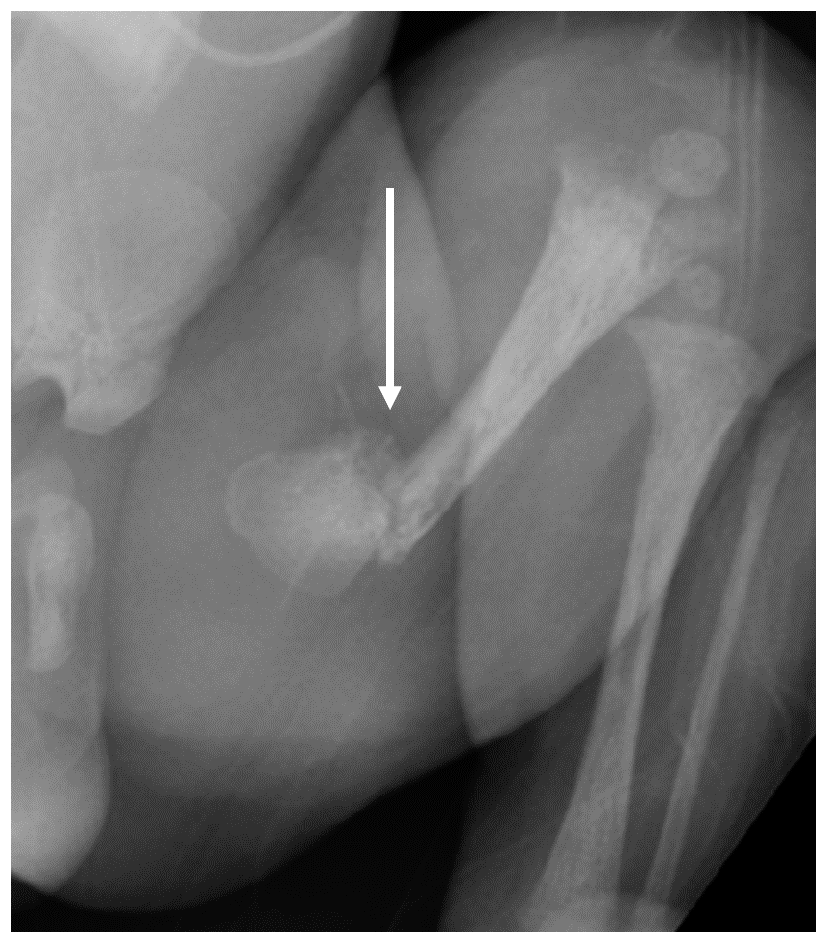
Figure 6. On the day of birth, there was surrounding callus formation and sclerosis surrounding the margins of the fracture of the left proximal femur (white arrow). There was a cortical irregularity in the distal metaphysis of the left femur, with faint lucency and no displacement of fragments. Holick MF, copyright 2021.